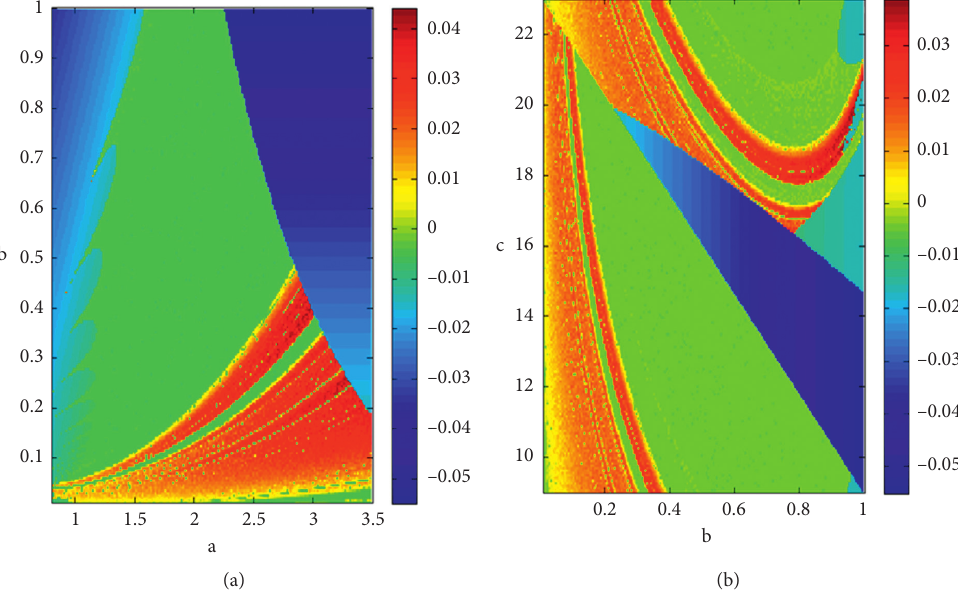
Figure 1: Two parameters LLE diagrams in (a) ( a,b ) space for c � 22 and (b) ( b, c ) space for a � 1 . 53.